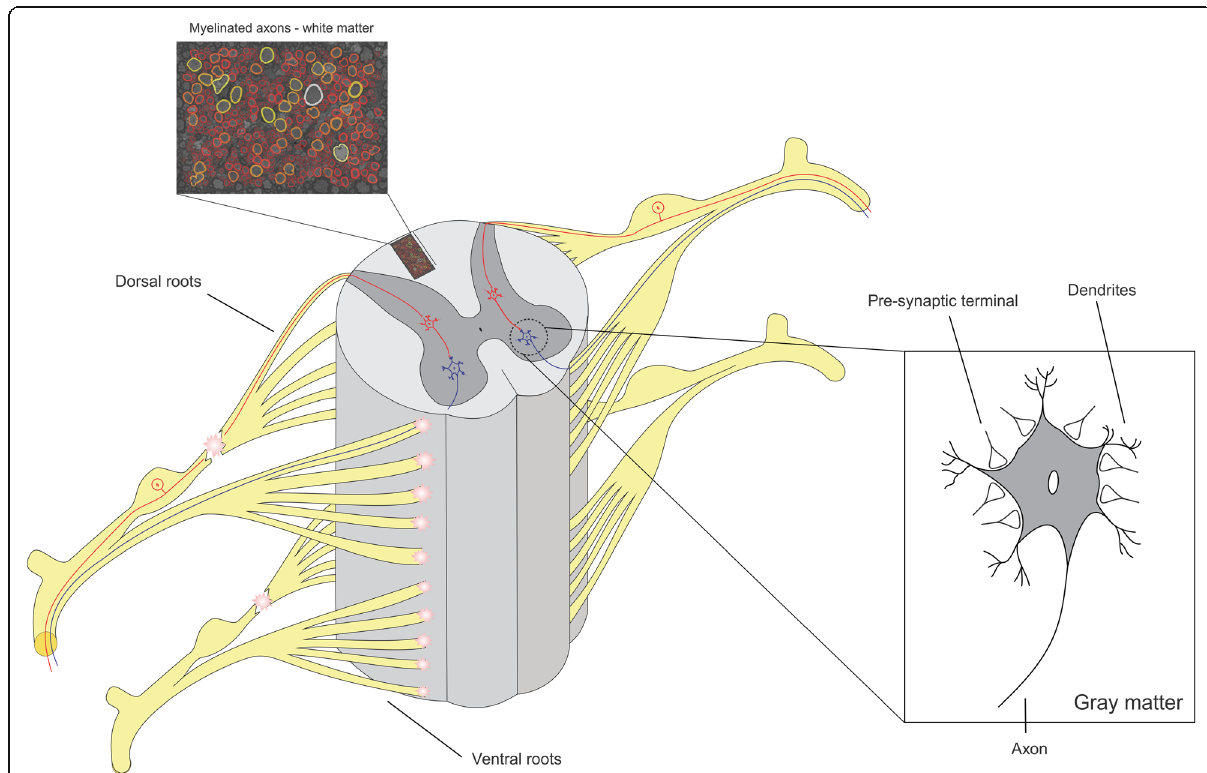
Fig. 1 Schematic view of dorsal and ventral nerve roots. Sensory neurons bring sensory inputs through the dorsal roots, which are transmitted to the motoneurons via interneurons. Motoneurons send their axons through ventral roots that innervate target muscles. Dorsal root lesion and ventral root avulsion have been used to evaluate the efficacy of the CEVAP heterologous fibrin sealant (HFS) for CNS repair and regeneration. The inset shows presynaptic terminals in apposition to motoneurons that retract after injury (synapse pruning). Myelinated axons located in the white matter are highlighted ( top left ) by using AxonSeg, an open source software for axon morphometry